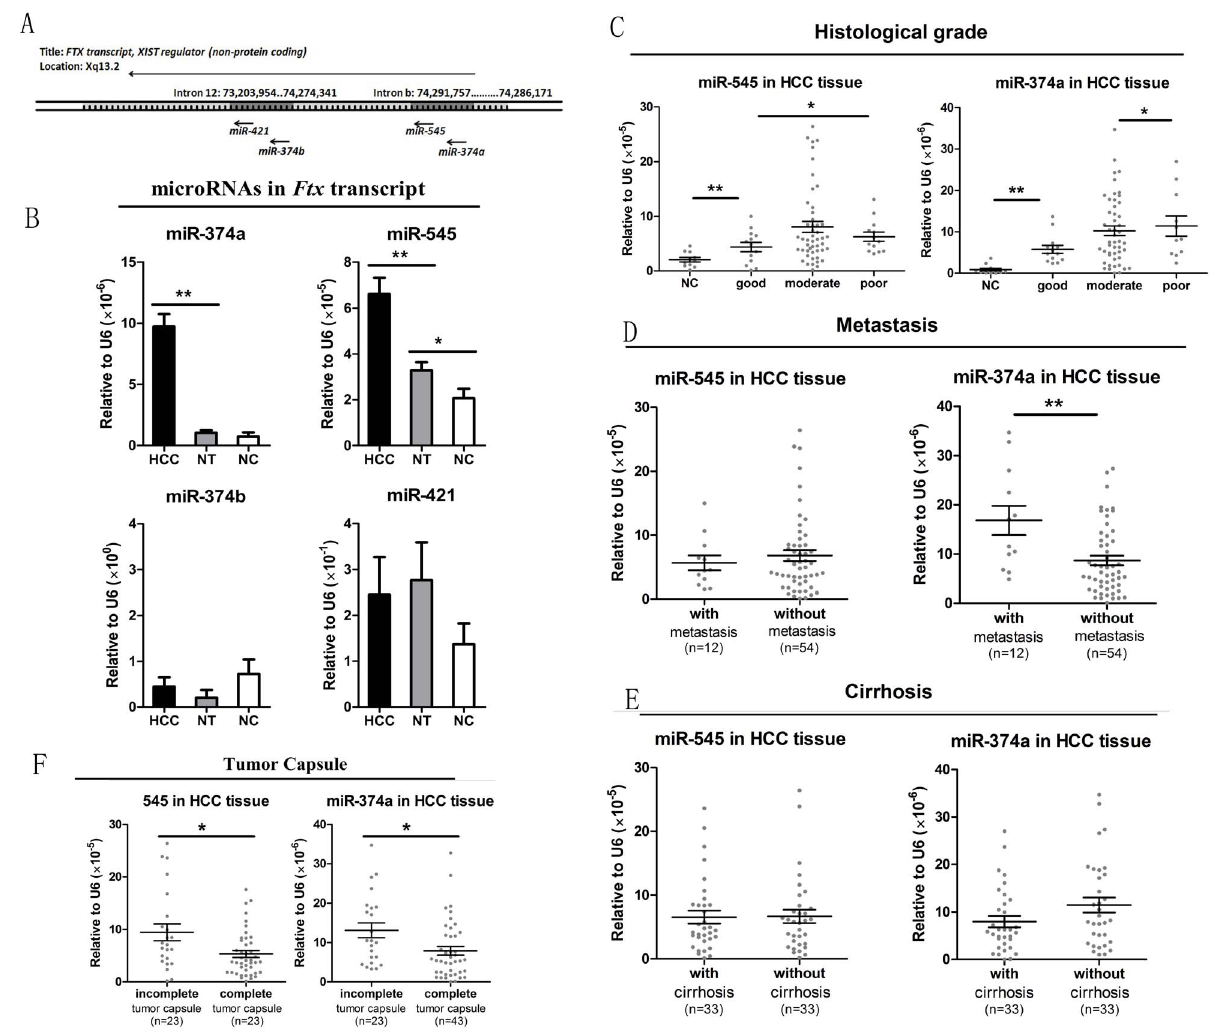
Figure 1. Expression pattern of microRNA clusters within the Ftx transcript and their correlation with key clinical features. (A) Genomic location of the Ftx microRNA clusters. Ftx contains a cluster of two microRNAs (miR-374b and miR-421) within intron 12 and a related cluster of two microRNAs (miR-374a and miR-545) within intron b. (B) Expression status of Ftx microRNA clusters (miR-374a, -545, -374b, -421) in human HBV- related hepatocellular carcinoma tissue (HCC; n=66), matched distal non cancerous liver tissue (NT; n=66) and negative control (NC; n=11). The levels of each microRNA were determined by qRT PCR of tissue specimens. The error bars in B represent mean 6 Std. error. *P , 0.05, **P , 0.01, t test. (C-F) Analysis of individual microRNA expression patterns with well established prognosis-related clinical features. The levels of each microRNA was determined by qRT PCR of tissue specimens. Pathological examination included histological grade, metastasis, cirrhosis, and tumor capsule as described in the methods. The error bars in C-E represent mean 6 Std. deviation. *P , 0.05, **P , 0.01, t test. HBx antibody (1:1000 dilution; Abcam, Cambridge, Massachu- setts, USA), followed by incubation with mouse anti-rabbit secondary antibodies (1:5000 dilution, Abcam). Protein bands were detected using an enhanced chemiluminescence reagent (Sigma, USA).